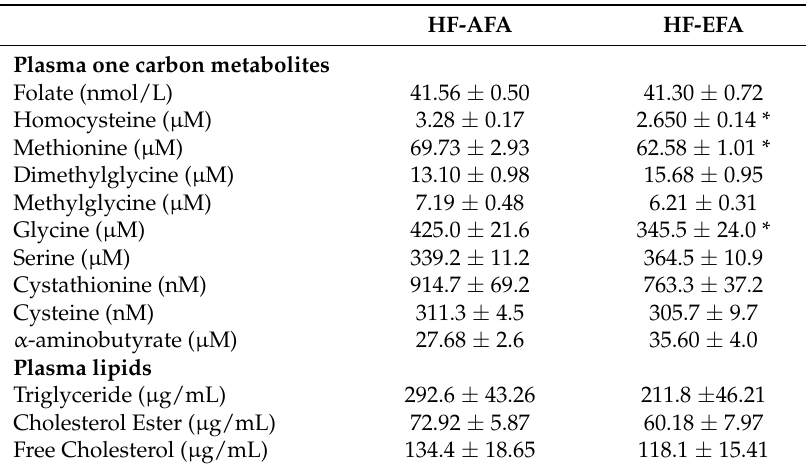
Table 2. HF-EFA fed rats experience alterations in plasma one carbon metabolite profile, while plasma lipids remain unchanged, compared to HF-AFA fed